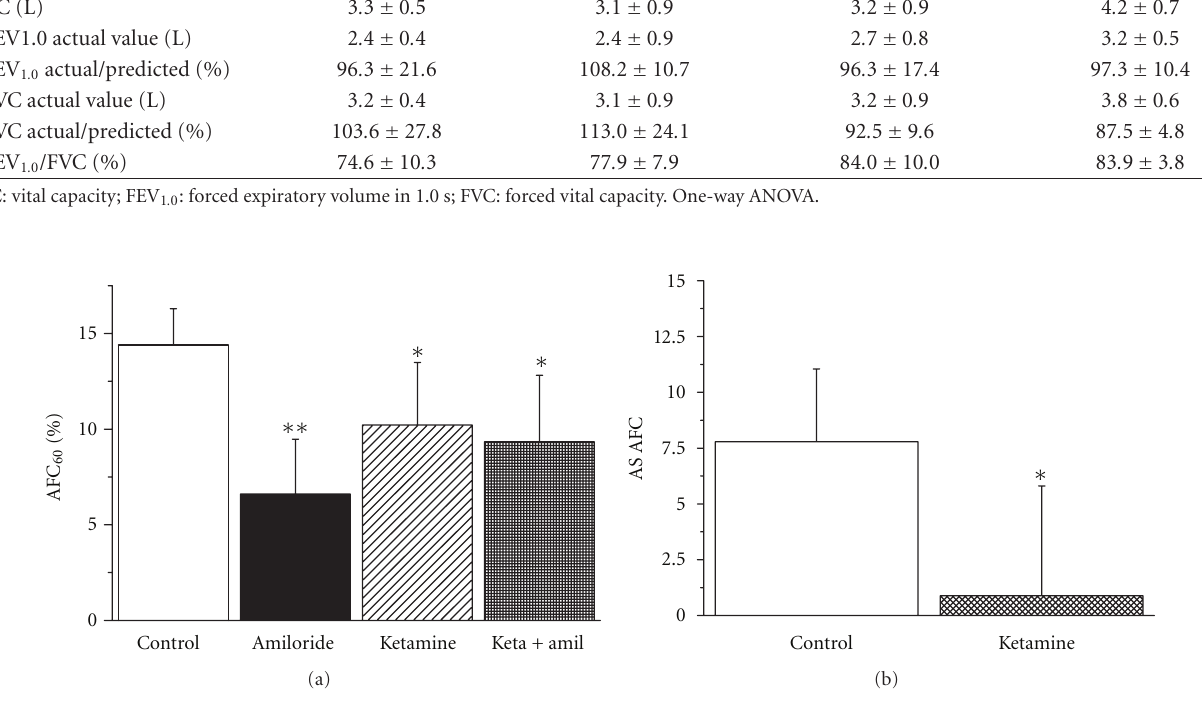
Figure 1: E ff ects of ketamine on alveolar fluid clearance in isolated human lungs. (a) Lungs were treated with 5% bovine serum albumin dissolved in physiologic saline solution in the absence of drugs (control), in the presence of amiloride (1mM), ketamine (100 μ M), and both (Keta + Amil). %AFC 60 represents the AFC percentage after 60 min. (b) Amiloride-sensitive (AS) AFC. Average AFC values are presented as the mean ± SEM, one-way ANOVA. ∗ P < 0 . 05, ∗∗ P < 0 . 01. n =